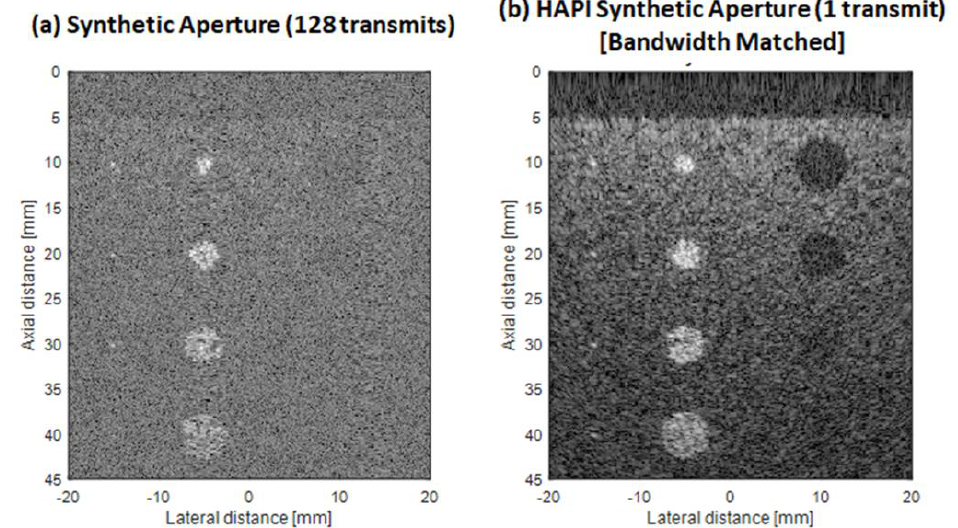
Figure 6. The 2D sparse array simulation images of the phantom with 4 hypoechoic cysts and 4 high scattering regions placed at decreasing depths (10 mm, 20 mm, 30 mm, 40 mm) for ( a ) synthetic aperture imaging using 128 transmits, and ( b ) Hadamard Aperiodic Interval synthetic aperture imaging using 1 transmit. Images are 2D slices of the x-z plane of a 3D volume displayed at − 55 dB.